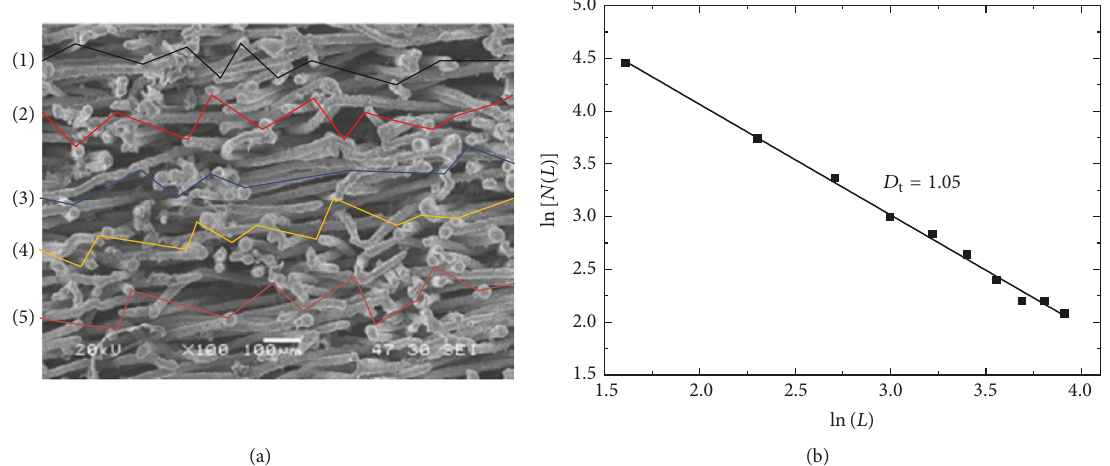
Figure 7: The results of the tortuosity fractal dimension 𝐷 t calculated by the box-counting method. (a) Five possible random sound propagation pathways; (b) the result of 𝐷 t for the first pathway.